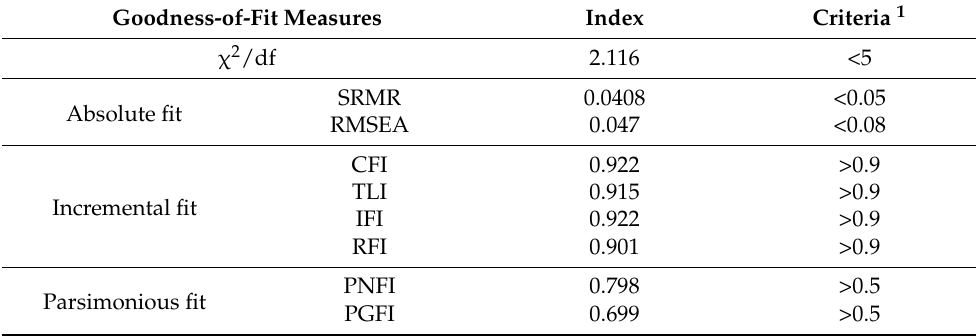
Table 6. Goodness-of-fit measures results (Source: Authors’ calculations).